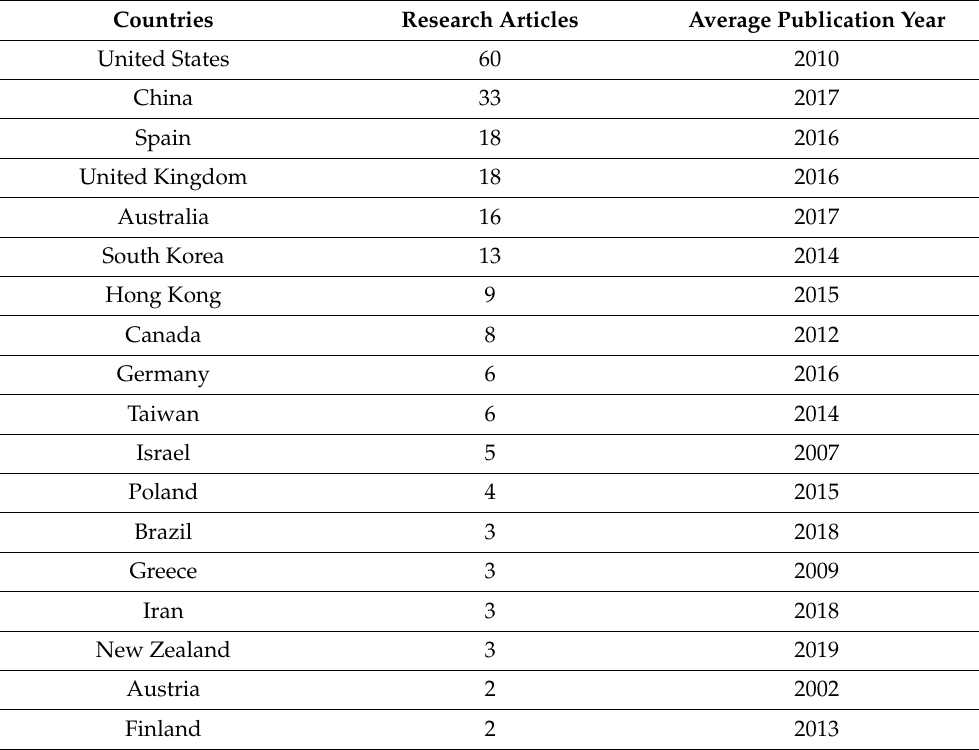
Table 2. Geospatial distribution of research articles on DTs in the AEC industry .